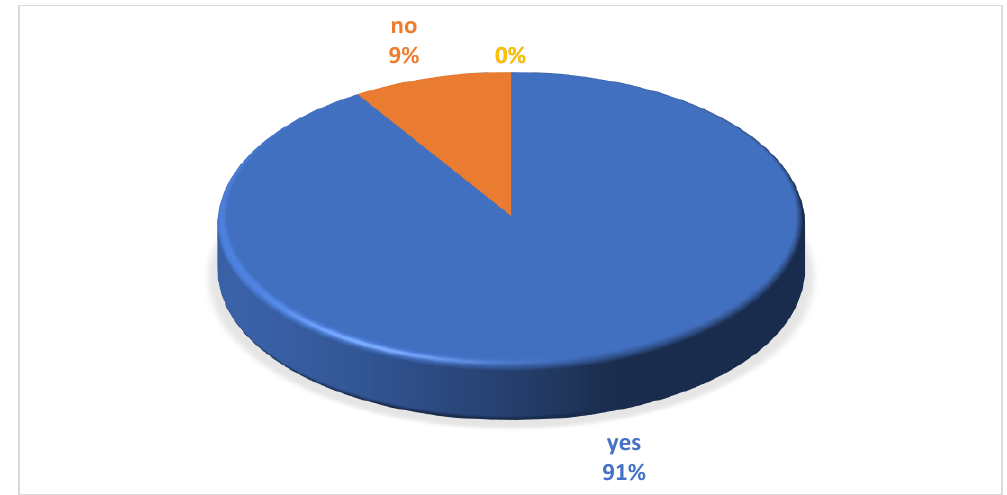
Figure 14. Possibility of obtaining energy from renewable sources for the commune’s own needs.